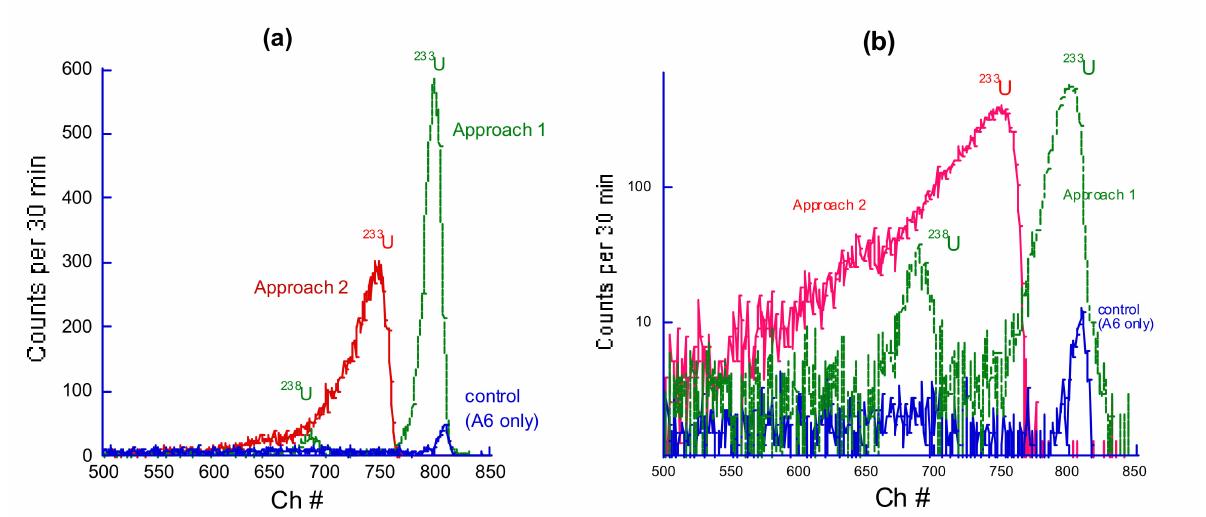
Figure 3. Linear ( a ) and logarithmic ( b ) representation of alpha spectra of uranium deposited on UF membrane in two different ways (Approach 1 and 2) in comparison to those deposited directly on the same membrane without polymer (control). The two peaks visible in Approach 1 correspond to the two isotopes of U present in the aqueous